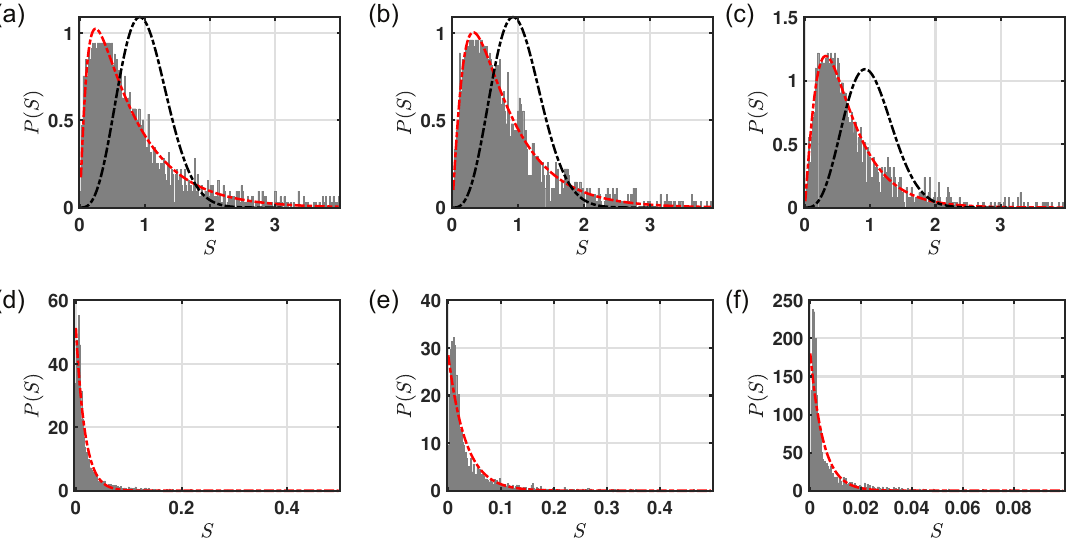
Figure 12. Level spacing statistics of the Green’s matrix eigenvalues for two different regimes: ρλ 2 = 0.05 (panels ( a – c )) and ρλ 2 = 50 (panels ( d – f )). Panels ( a , d ), ( b , e ), ( c , f ) refer to EC DL H , EC DL M , and EC DL L configurations, respectively. The fitting curves are performed by using the critical cumulative distribution [25,43,46] (dotted dashed lines in panels ( a – c )) and the Poisson distribution (dotted dashed lines in panels ( d – f )). The dotted dashed black lines in panels ( a – c ) indicates the level spacing distribution of a representative UR structure defined by Equation